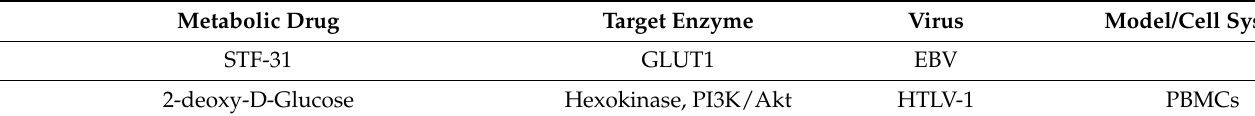
Table 1. Antiviral effects of metabolic inhibitors